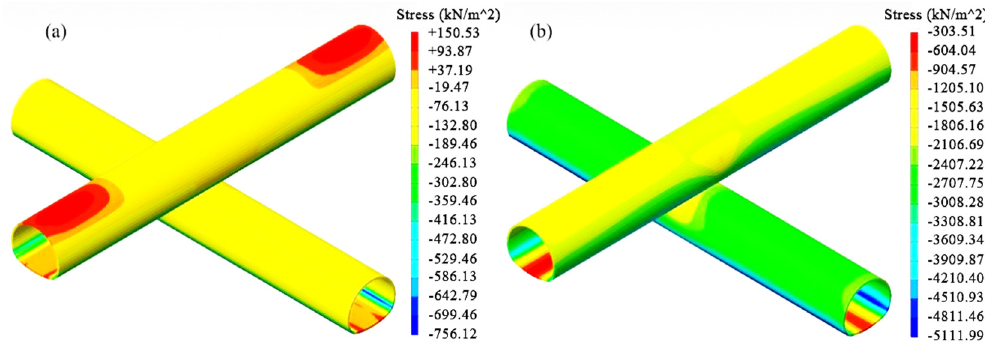
Figure 7. Initial stress distribution: (a) Maximum tensile stress, σ 1; (b) maximum compressive stress, σ 3.